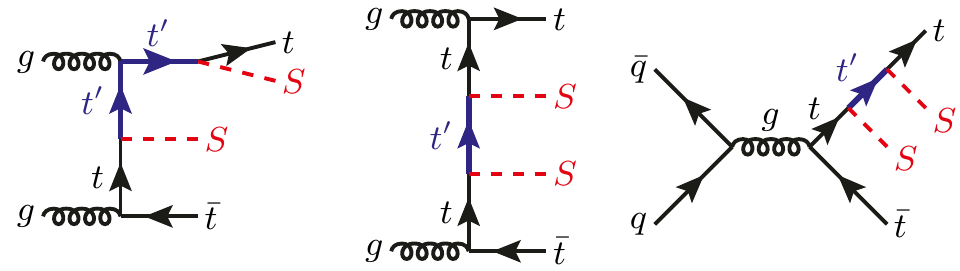
Figure 16 . Examples of topologies containing at least one t (cid:12)nal state for the process pp ! t (cid:22) tSS